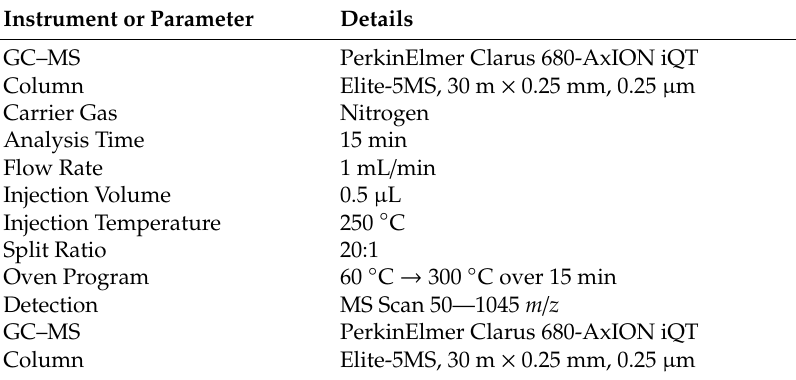
Table 1. GC–MS specifications and run conditions.